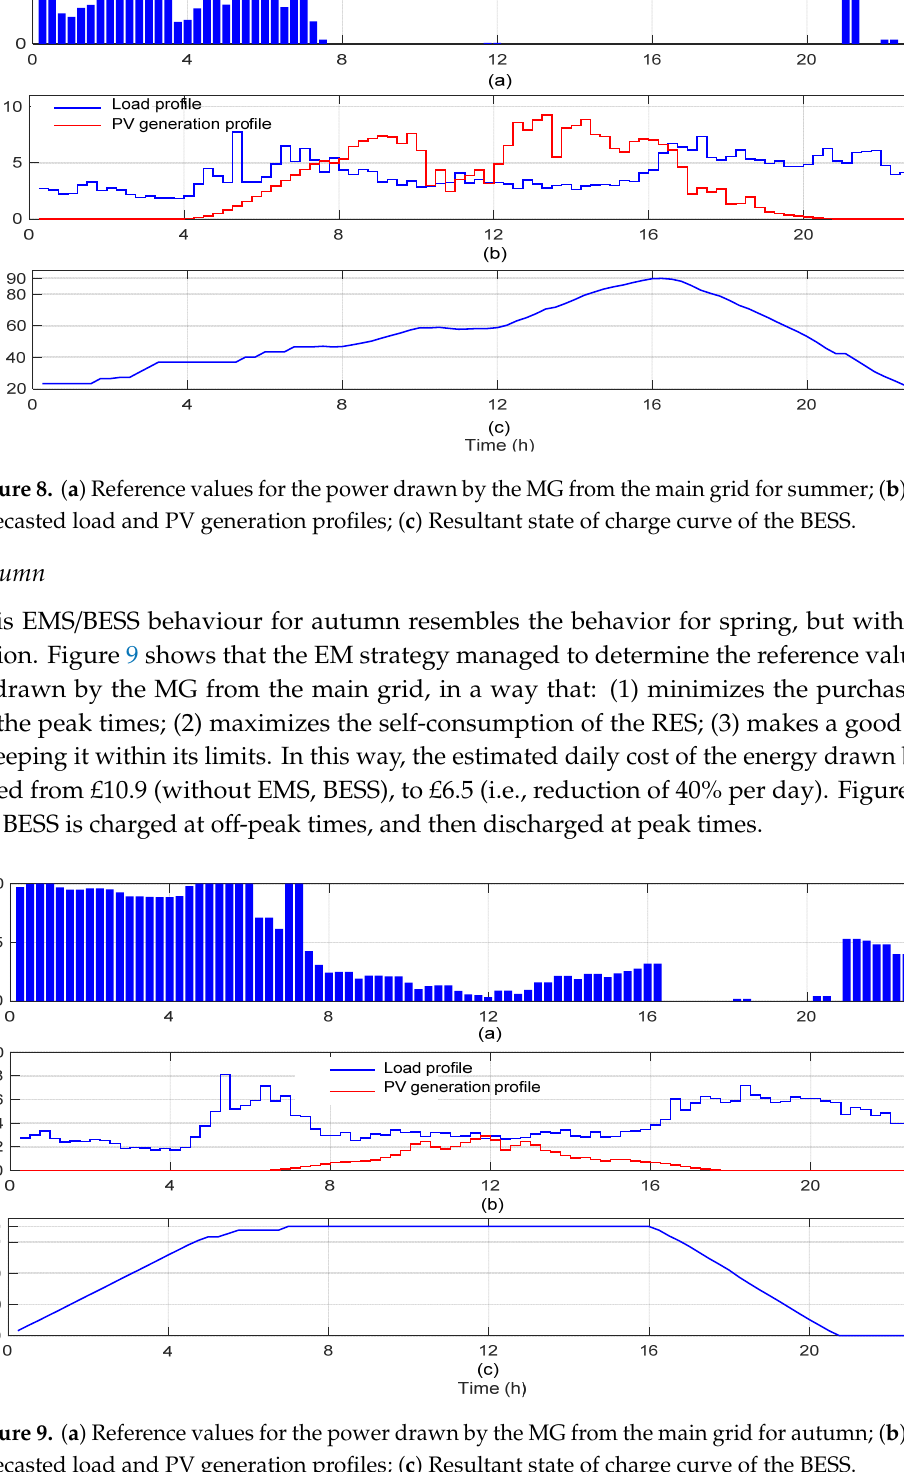
Figure 10. ( a ) Reference values for the power drawn by the MG from the main grid for winter; ( b ) MG’s forecasted load and PV generation profiles; ( c ) Resultant state of charge curve of the BESS. 6.5. Economic Analysis The overhead incurred by using a very short sampling time can be summarized in terms of payments and incomes. Payments include the cost of the required infrastructure for data collection and processing for a sample time of 1 min. The income is the extra reduction in daily operating costs that can be achieved compared to previous methods with a long sample time. For the proposed EMS, the required infrastructure needed for data collection and processing is the same as that used for any other MGEM system. This infrastructure consists of measurement devices, data aggregators, signal processing servers, and a communication network. The only difference for the case of using the proposed EMS is that the data collection and processing needs to be achieved in a 1 min sample time. This can still be achieved using relatively low-cost data acquisition and communications equipment.